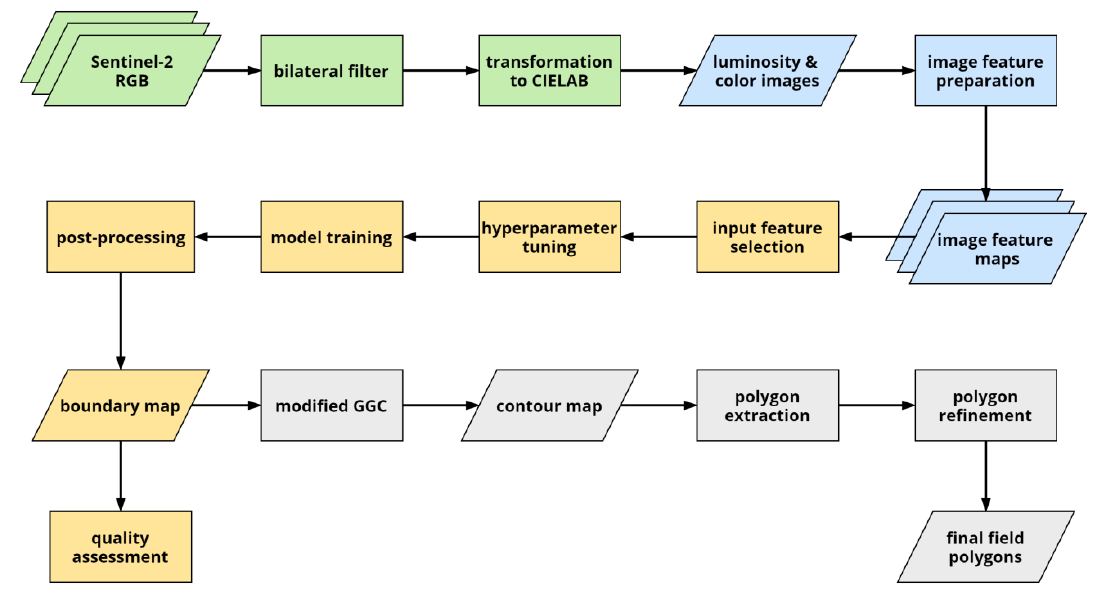
Figure 2. Flowchart of the methodology. Different stages highlighted in colors: pre-processing in green, image feature preparation in blue, boundary detection model development in yellow, and contour detection and field polygon extraction in grey.